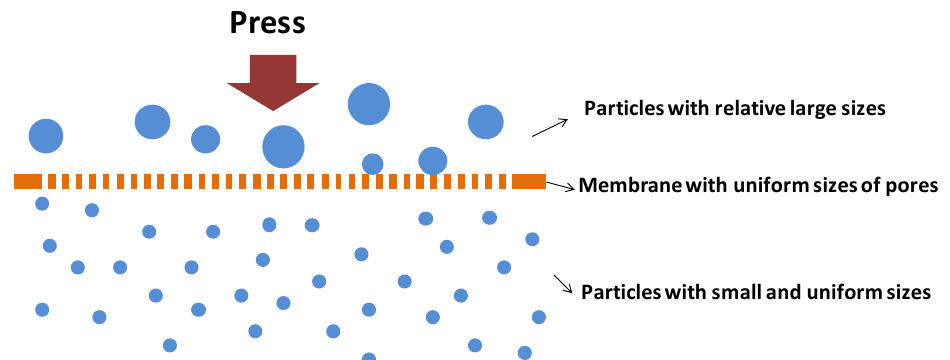
Figure 5. Schematic description for the process of rapid membrane emulsification.